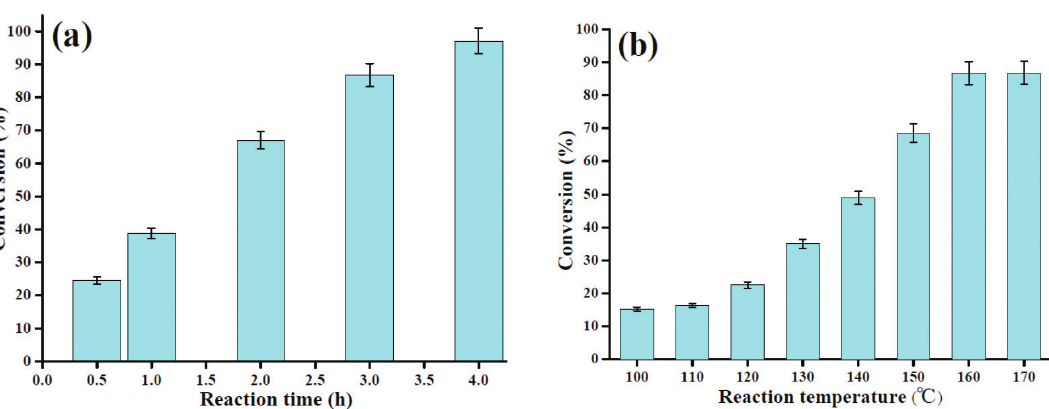
Figure 5: Effect of (a) reaction time (molar ratio of oleic acid to methanol: 1:18, catalyst amount: 180 mg, and reaction temperature: 160°C) and (b) reaction temperature on esterification of oleic acid (molar ratio of oleic acid to methanol: 1:18, catalyst amount: 180 mg, and reaction time: 3.0 h).